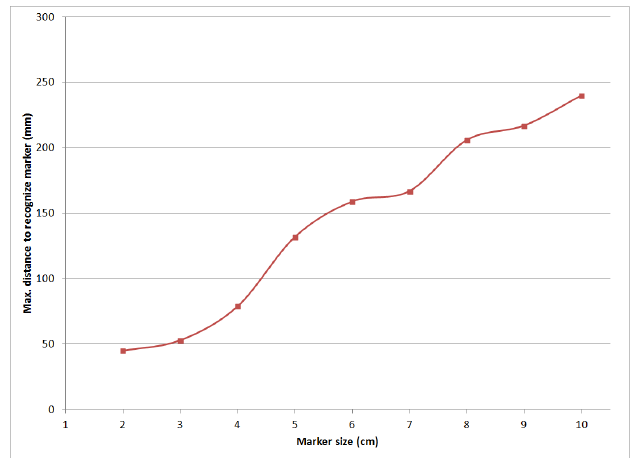
Figure 17. Maximum dynamic marker detection distance versus marker size.